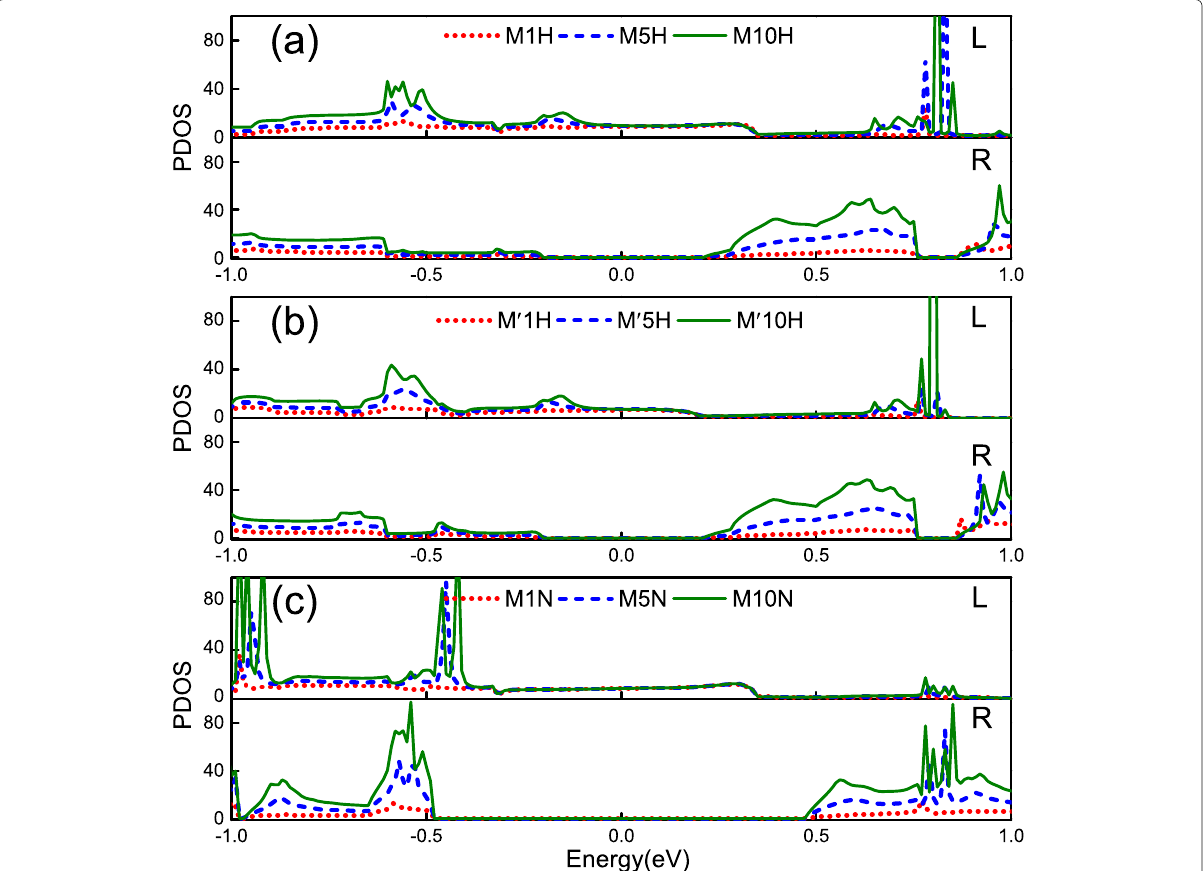
Fig. 7 The projected density of states (PDOS) of the left unpassivated ZBNR electrode (upper) and the right electrode (1H-Z α BNR, 2H − ZBNR, or N-Z α BNR) (lower) for a M n H, b M (cid:2) n H, and c M n N with the same choice of n in line colors for Fig. 5,